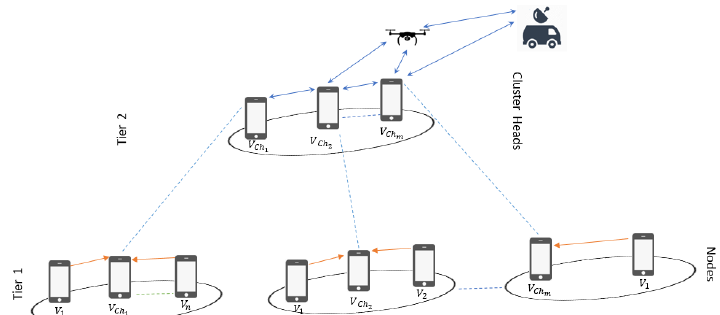
Figure 3. Two-tier